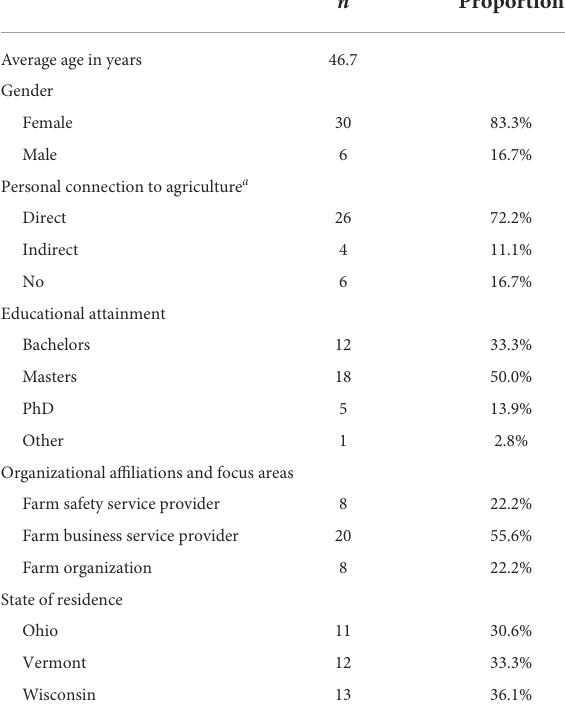
TABLE 1 Characteristics of interviewees ( n =